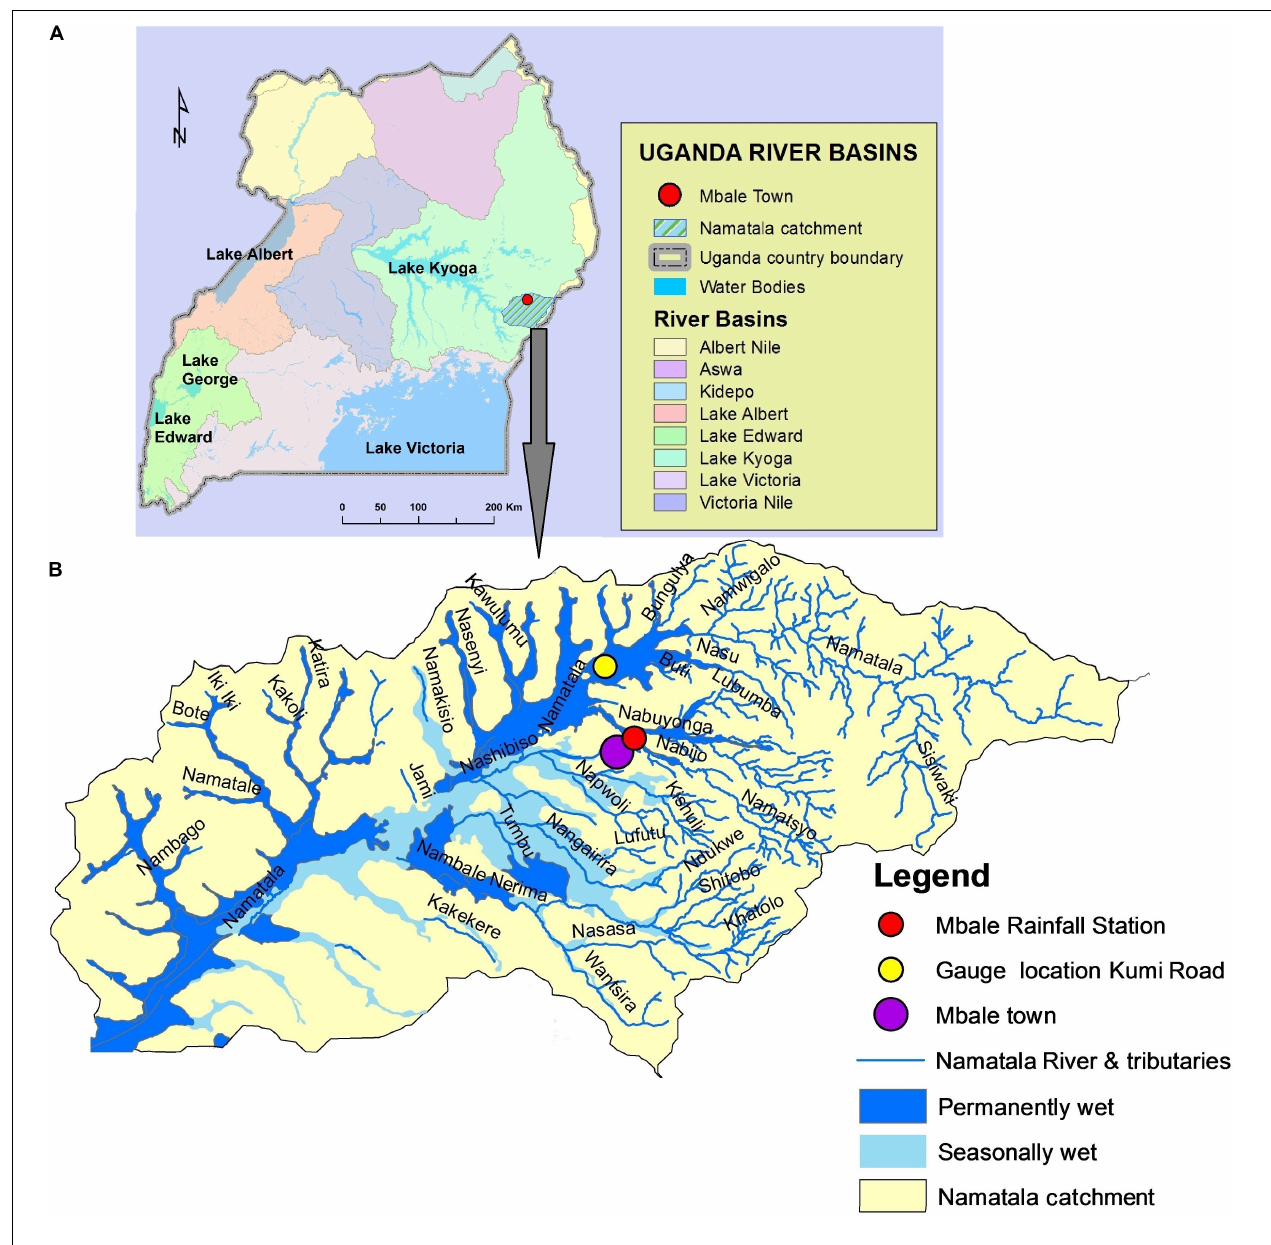
FIGURE 1 | (A) Location of Mbale town and Namatala Wetland within Uganda; (B) Drainage system of Namatala Wetland. Data source: Mapping and Inventory Centre, National Forestry Authority Uganda, 2005. Maps produced by authors.